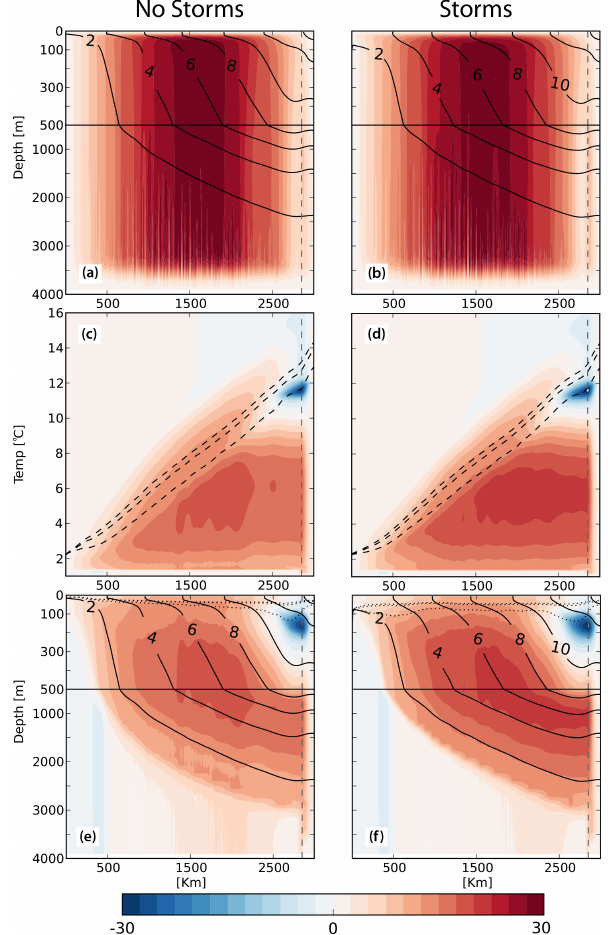
Figure 7. Eulerian mean streamfunction ψ (a, b) , MOC stream- function diagnosed in isopycnal coordinates (c ,d) and projected back to depth coordinates (e, f) from 10-year long 2km equilibrated simulations with (right) and without storms (left). Units are Sv and the contour interval is 0.25Sv. Temperature contours corresponding to 2, 4, 6, 8, 10, 12 and 14 ◦ C are indicated in (c, d) . Positive cells are clockwise. The dashed lines in (c, d) represent the 10, 50 and 90% isolines of the cumulative probability density function for sur- face temperature (following Abernathey et al., 2011), which indi- cate how likely a particular water mass is to be found at the surface exposed to diabatic transformation. Dotted lines in (e, f) represent (from top to bottom) the 90, 50 and 10% isolines of the cumula- tive probability density function for mixed-layer depth. The verti- cal dashed line at y = 2850km represents the limit of the northern boundary damping area. Model transports have been multiplied by 10 in order to scale them to the full Southern Ocean.